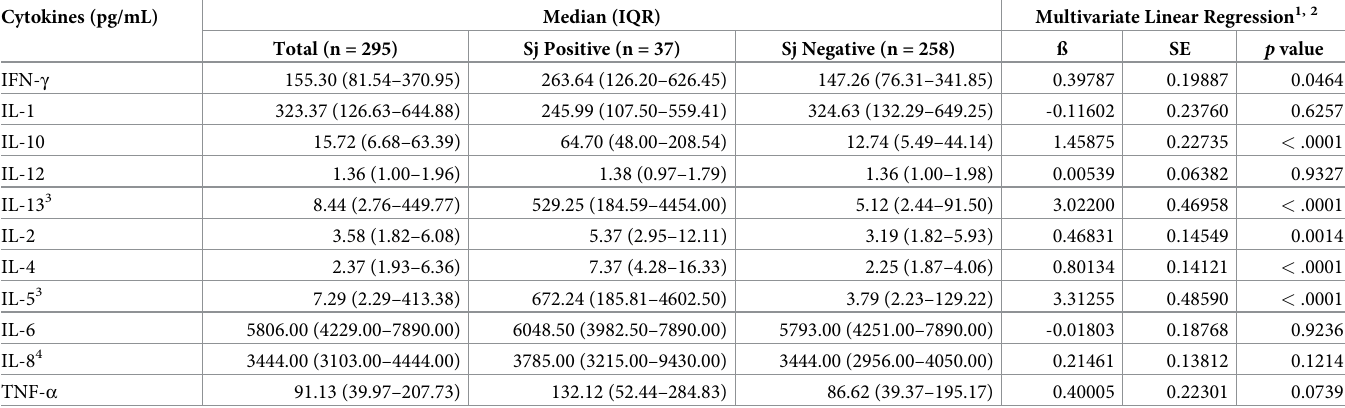
Table 4. Association between S . japonicum infection and SEA-stimulated cytokines. Cytokines